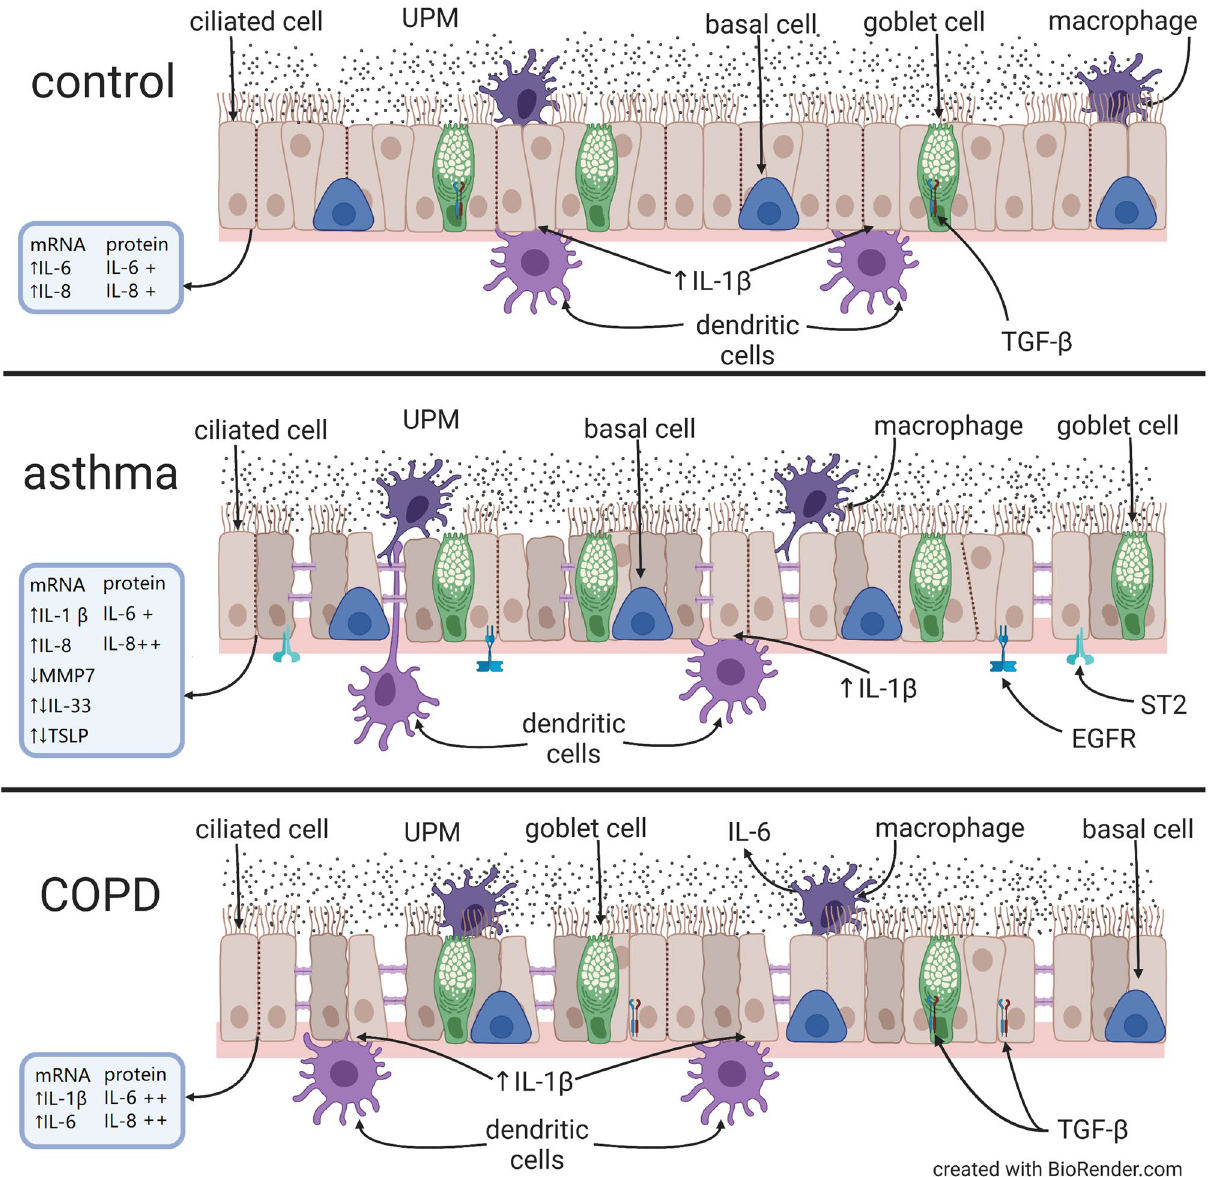
Figure 14. A schematic description of the study